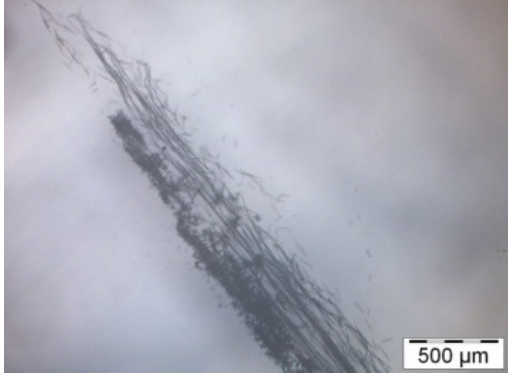
Figure 15. α -HH out of DH after 240 min of hydration.